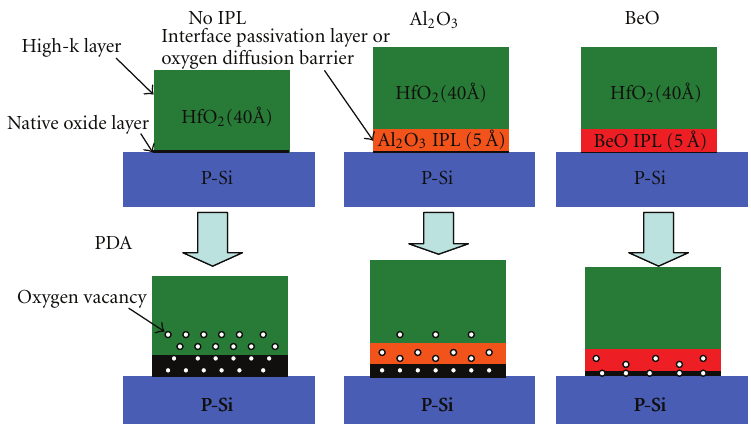
Figure 1: Cross-sectional MOS devices with various IL. The BeO interfacial layer is placed between HfO 2 and p-type Si substrate.